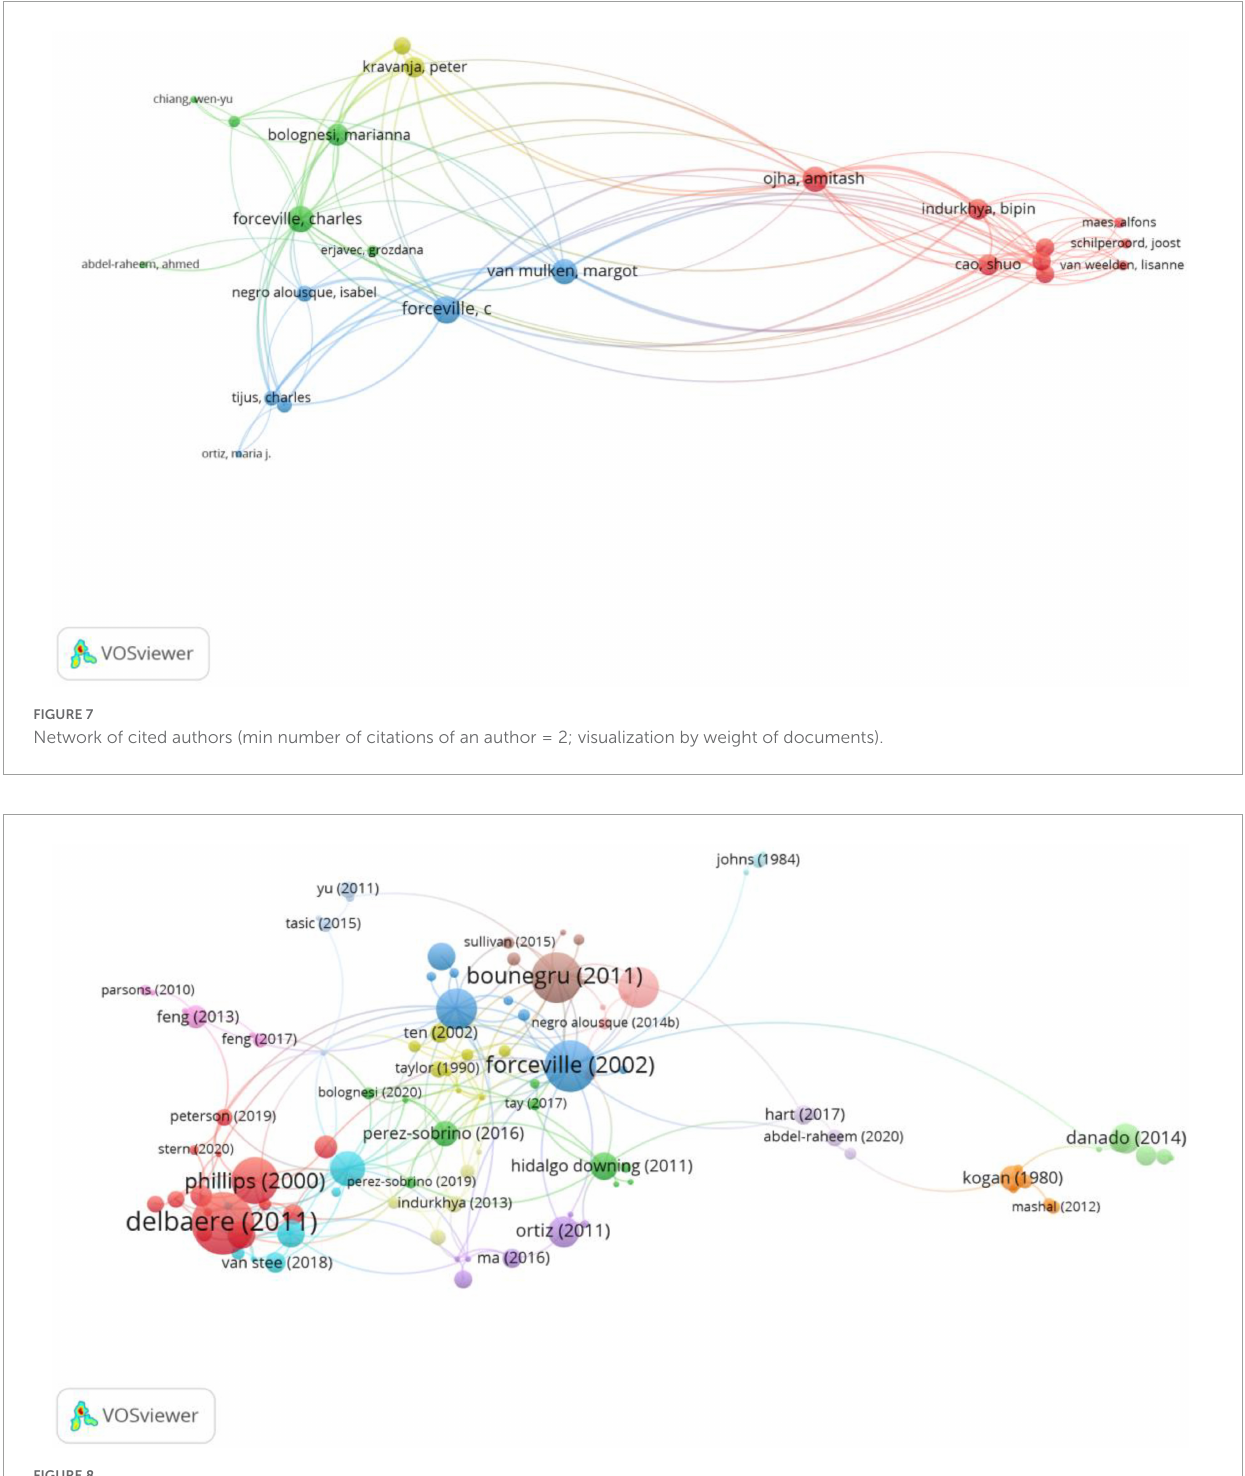
multimodal metaphor